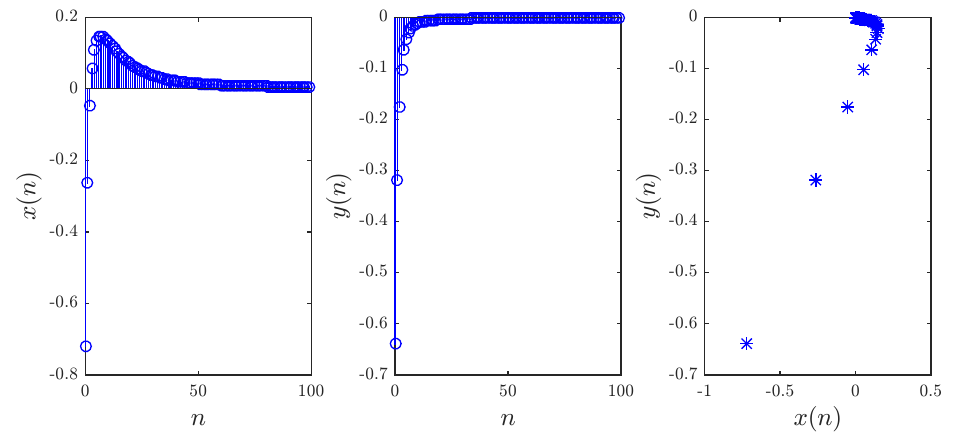
Figure 9. Stabilized states of the controlled fractional Tinkerbell map (11) with parameters ( α , β , γ , δ ) = ( 0.9, − 0.6013,2,0.5 ) , initial conditions ( x ( 0 ) , y ( 0 )) = ( − 0.72, − 0.64 ) , and fractional orders ( υ ( 0.99,0.95 )